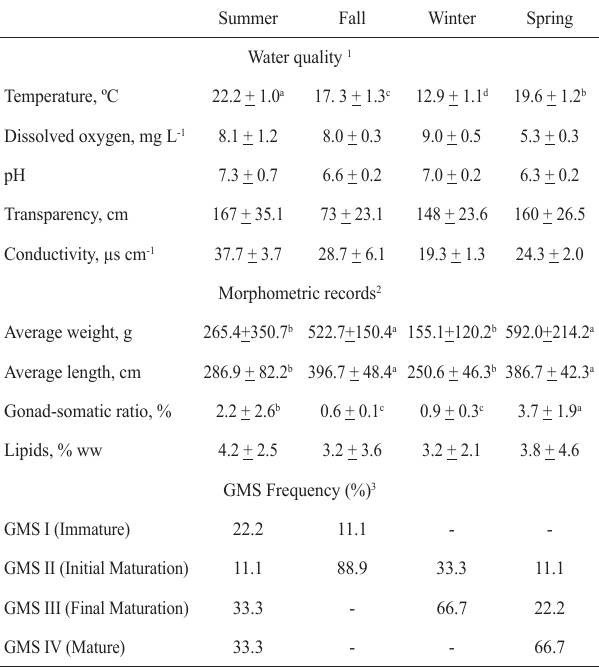
Table 1. Water quality variables of upper rio Uruguay, morphometric records and frequency of female Rhamdia quelen maturation stages of captured in each season. 1 The figures for each station are averages of the four sampling points. 2 Averages for each season were calculated with nine females. Weight magnitude in g for each season was: summer = 53 to 1184, autumn = 342 to 754, winter = 73 to 447, spring = 355 to 987. Length range in cm for each station was: summer = 217 to 460, autumn = 335 to 495, winter = 207 to 350, spring = 332 to 454. 3 GMS = gonadal maturation stage. According to Girhaldelli (2007): GMS I = Immature (gonad-somatic relationship (GSR) < 0.4); GMS II = Initial maturation (0.4 < GSR < 0.8), GMS III = final maturation (0.8 < GSR < 2) and GMS IV = Mature (GSR> 2). 3 The values are average +